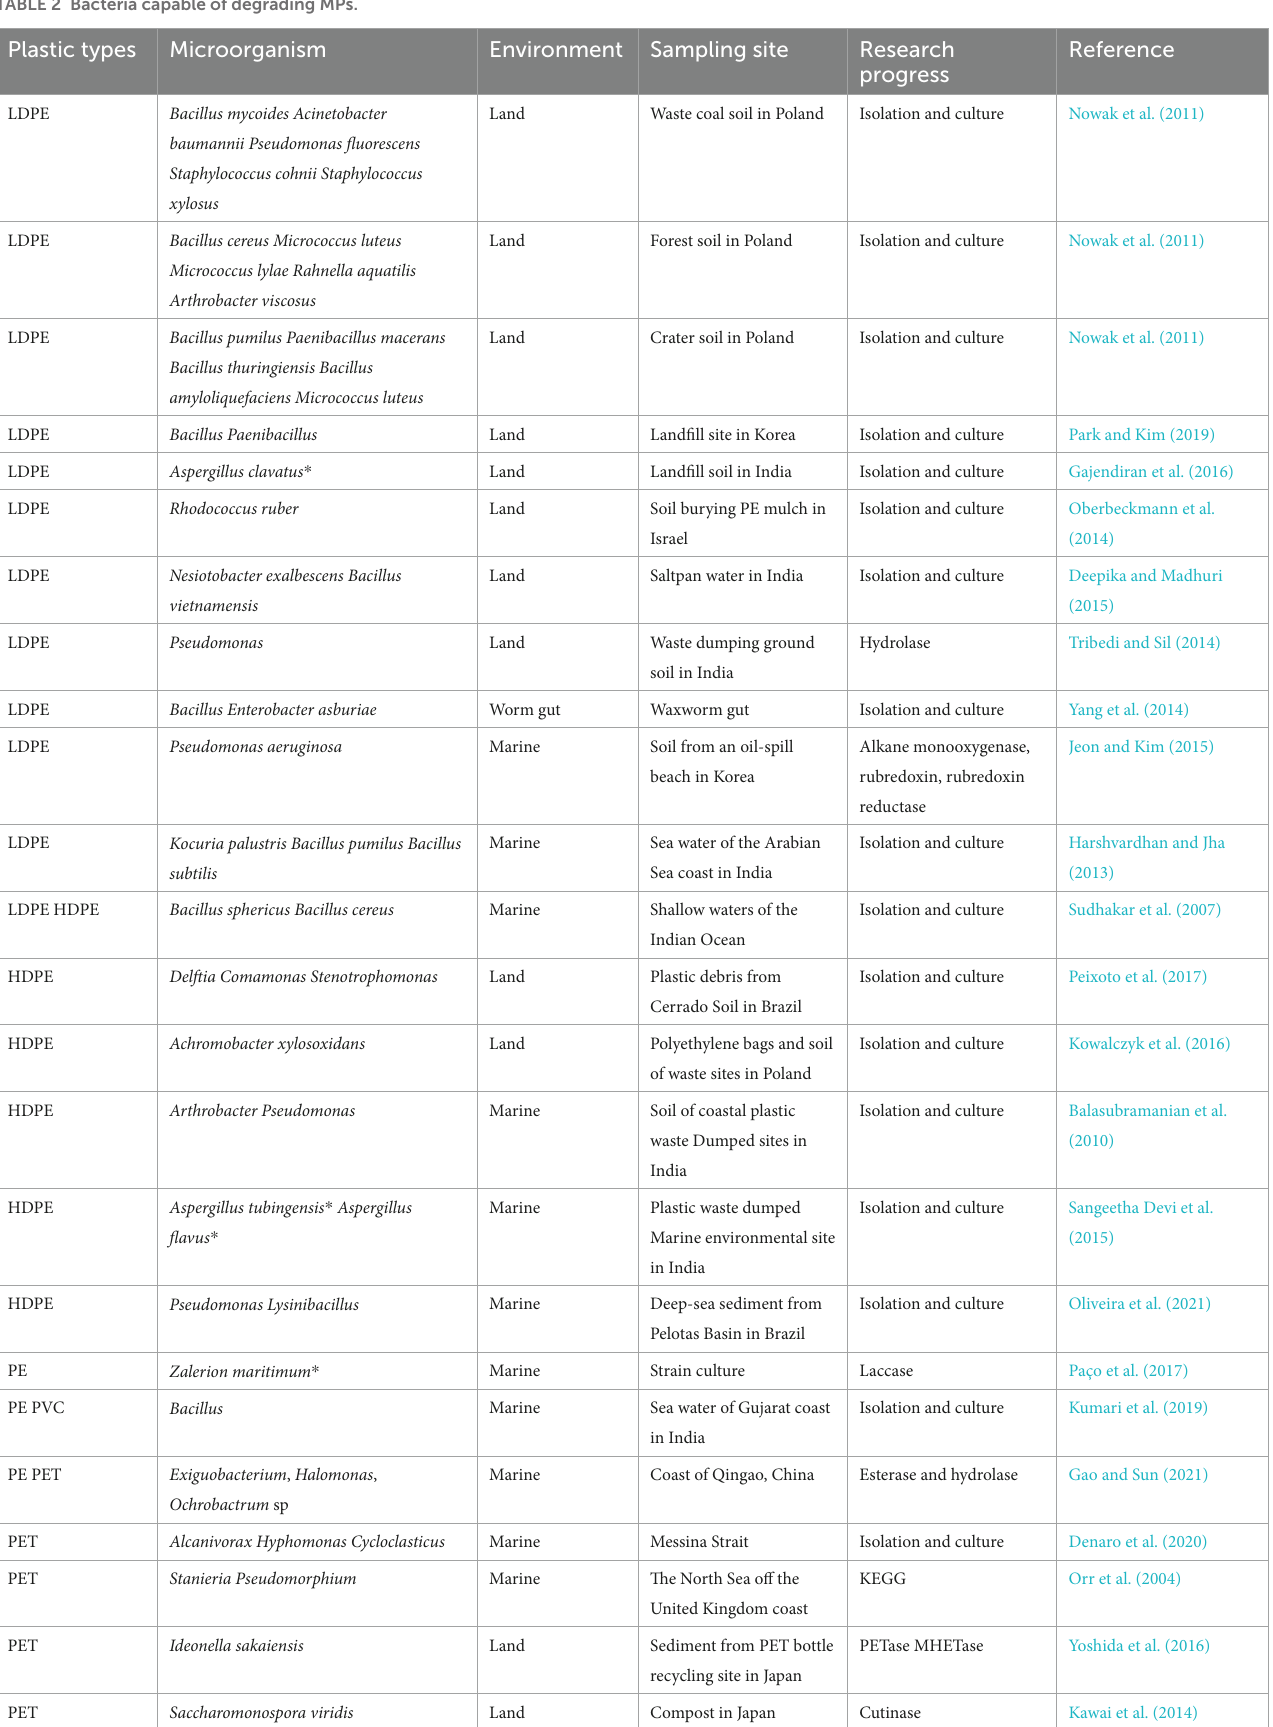
TABLE 2 Bacteria capable of degrading MPs. Plastic